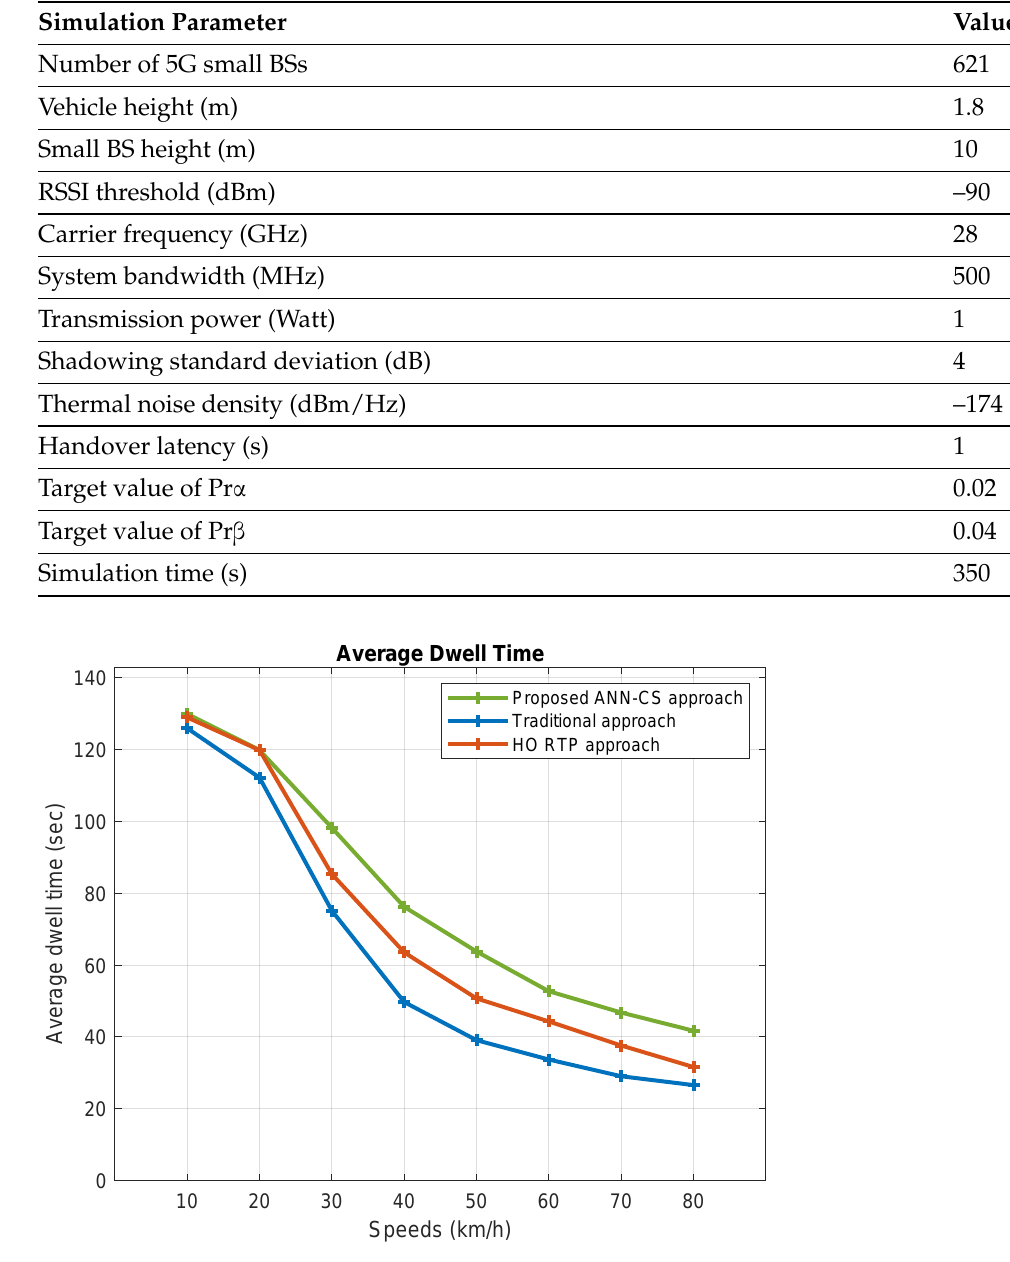
Figure 9. Average dwell